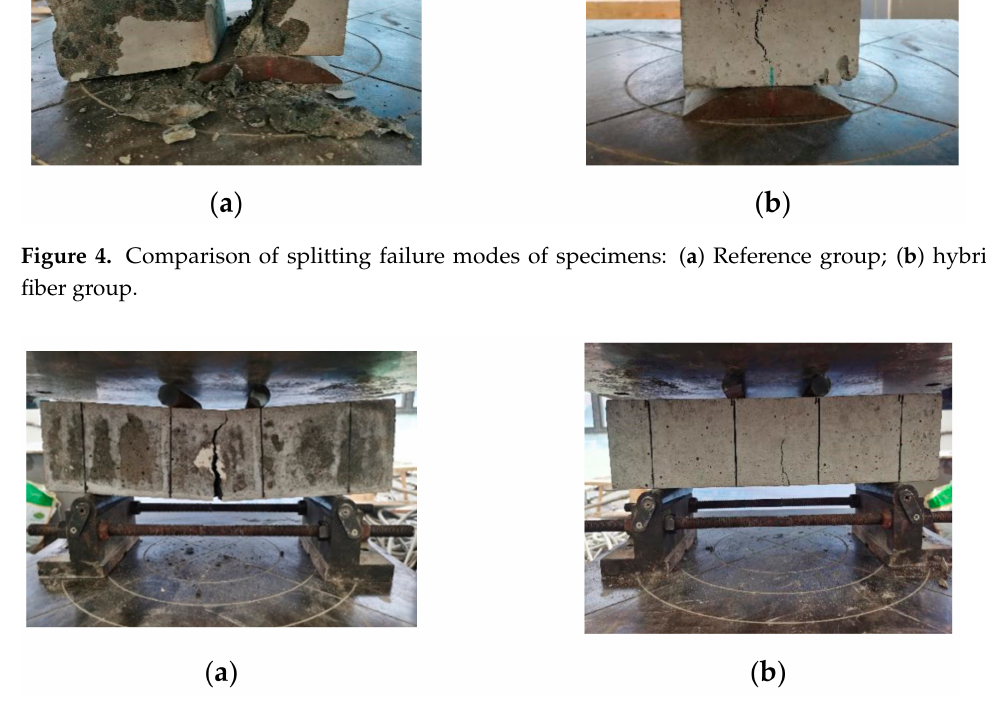
Figure 5. Comparison of flexural failure modes of specimens: ( a ) Reference group; ( b ) hybrid fiber